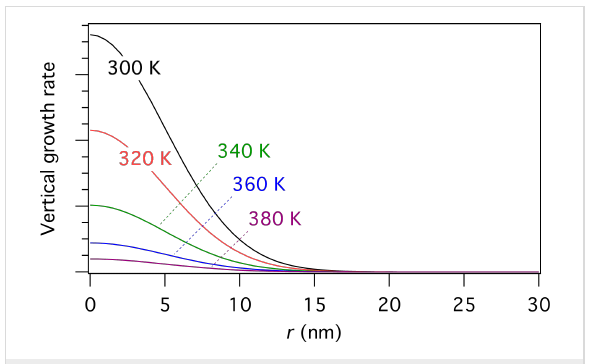
Figure 8: Steady state growth rate versus r calculated at a number of substrate temperatures using Equation 15 and a Gaussian electron flux profile (Equation 8, Ω = 5